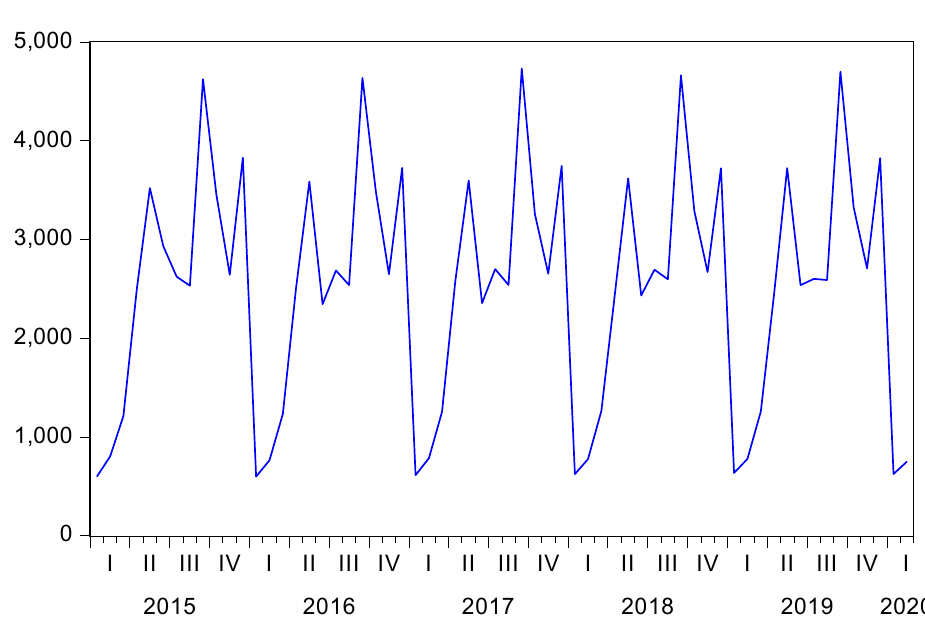
Figure 6. Evolution of enotourism demand in the Montilla-Moriles PDO (thousand tourists, January 2015 February 2020). Source. Own elaboration.